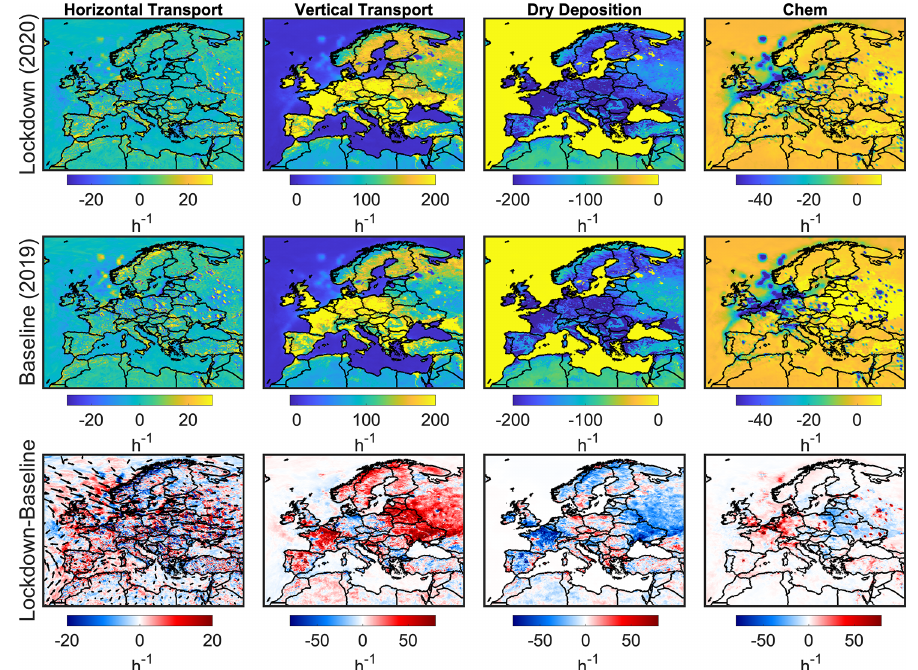
Figure 8. Surface process tendencies (h − 1 ) including horizontal transport (advection plus diffusion), vertical transport (advection plus diffusion), dry deposition, and chemistry. Positive (negative) values mean source (sink) of ozone. These outputs are based on the constrained model. Wind vectors are the